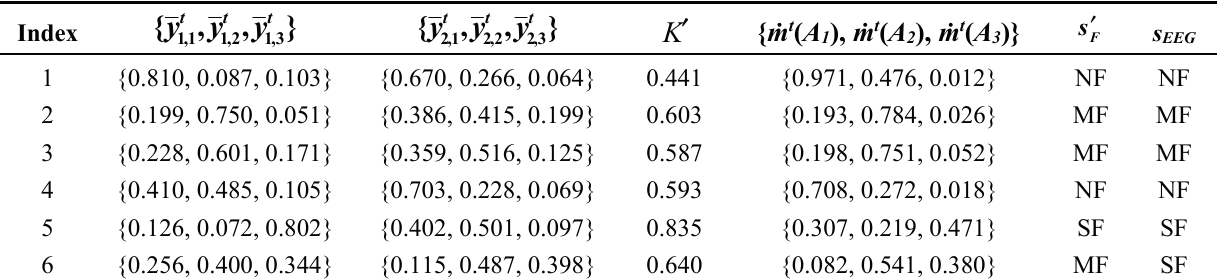
Table 7. Recognition results of the first evidence